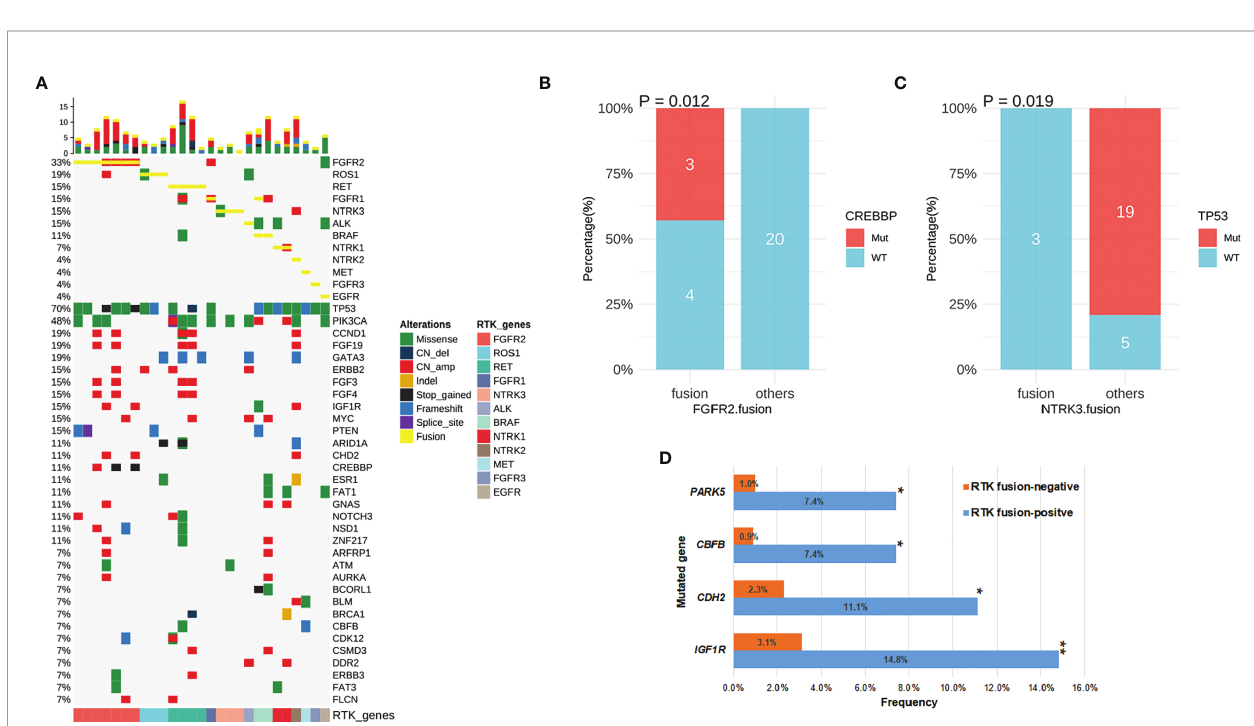
FIGURE 4 | The concomitant mutations in RTK fusion-positive patients. (A) The oncoprint of 27 breast cancer patients with RTK fusion. (B) CREBBP mutation frequency in patients with FGFR2 fusion vs. those with other RTK fusion. (C) TP53 mutation frequency in patients with NTRK3 fusion vs. those with other RTK fusion. (D) Comparison of mutation frequency in RTK fusion-positive vs. negative patients. *P-value <0.05; **P-value